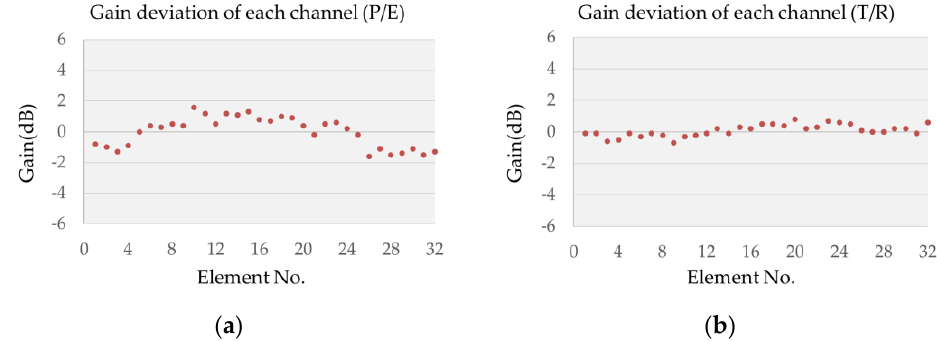
Figure 13. FPAPr amplitudes of elements: ( a ) P/E type FPAPr; ( b ) T/R type FPAPr. Table 3. Specifications of the FPAPr probes applied to the experiment.